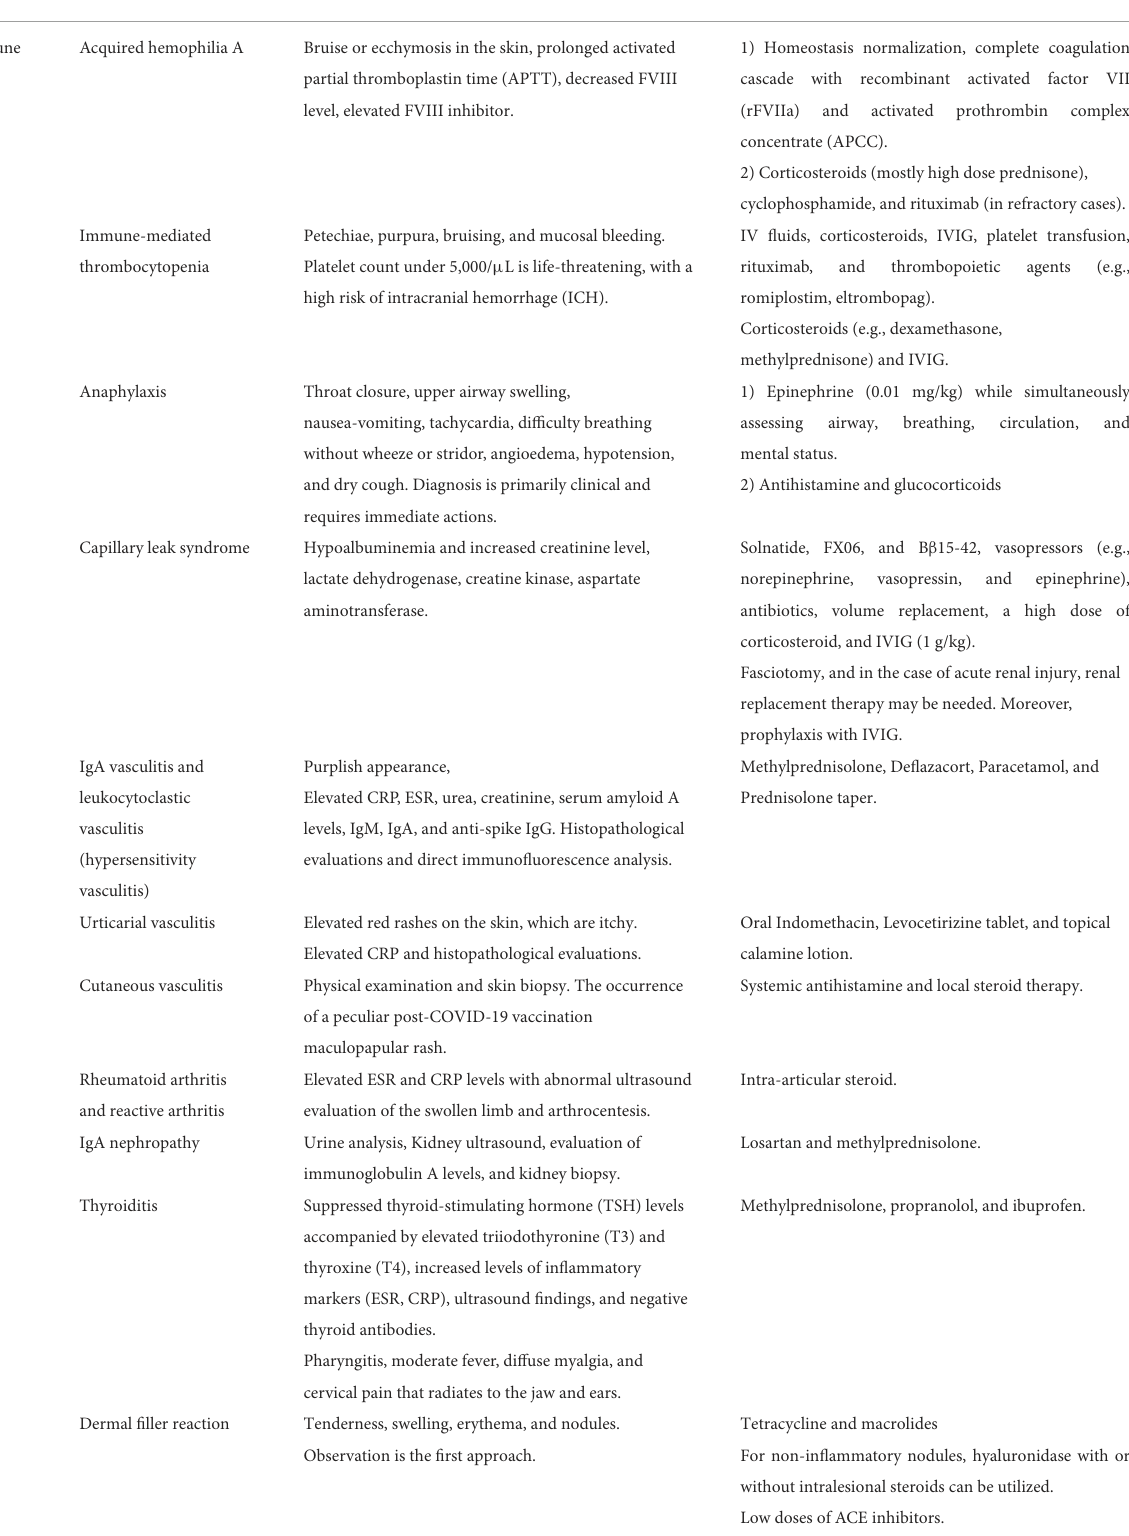
TABLE 2 Summary of the rare adverse events following COVID-19